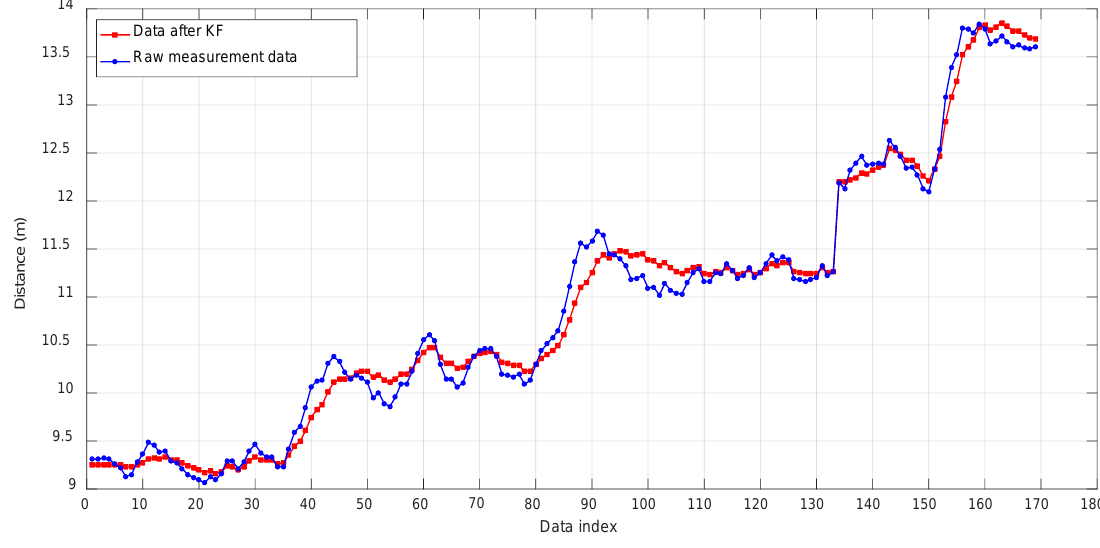
Figure 19. Tracking and ranging results of the long-pool experiment. Table 2. Comparison between the actual distance and the measurement data.